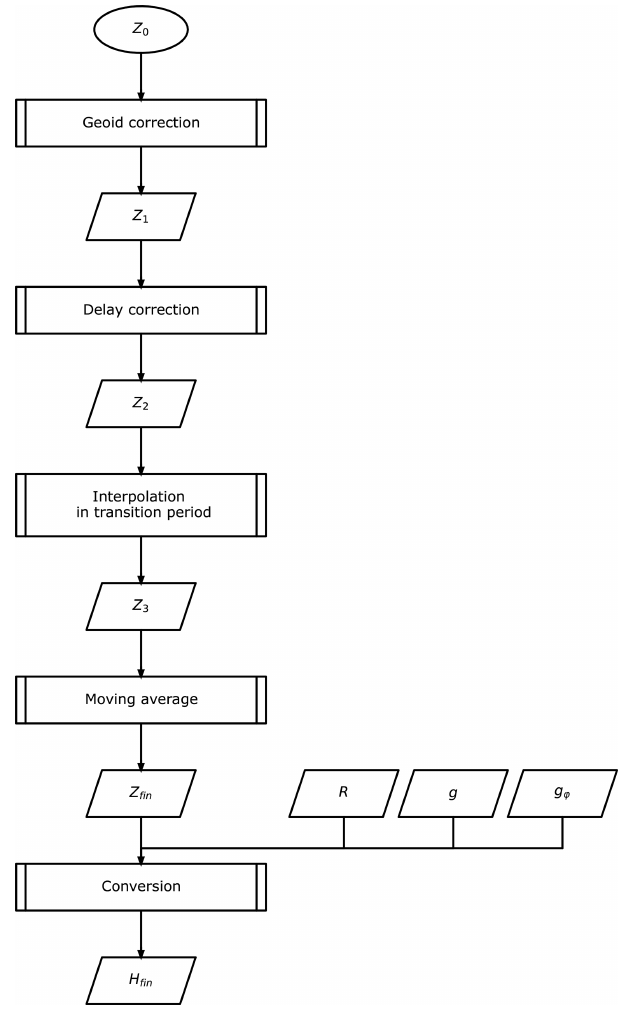
Figure 6. As per Fig. 3 but for geometric altitude, Z , and geopoten- tial height, H .